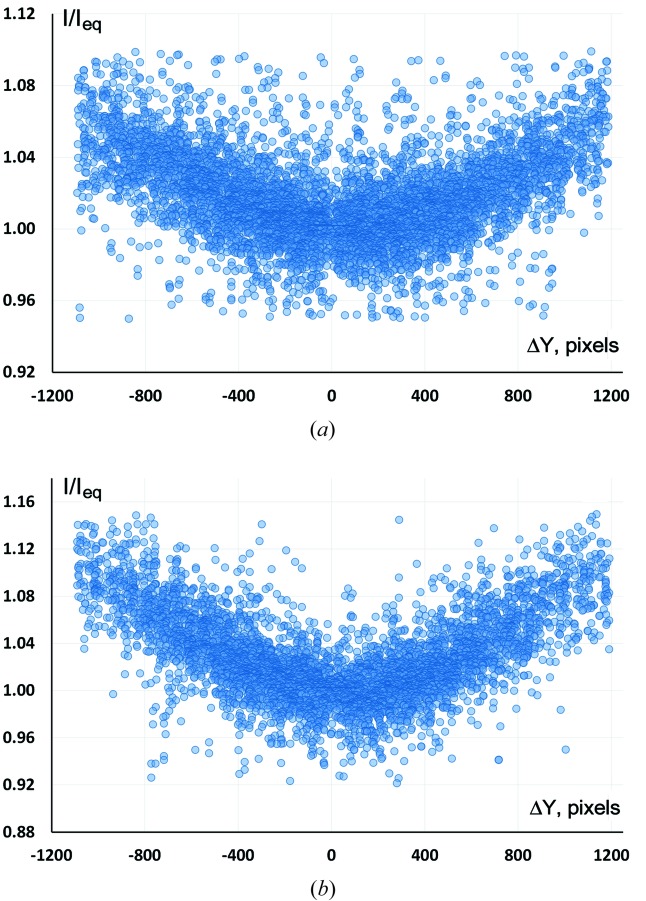
Oblique incidence effect for RAXIS RAPID detector with (a) Mo Kα and (b) Ag Kα radiaton, determined from a spherical ruby crystal and plotted as a function of vertical distance from the equatorial plane in pixels, based on intensity ratios of equivalents to the one within ±100 pixels from the equatorial plane.